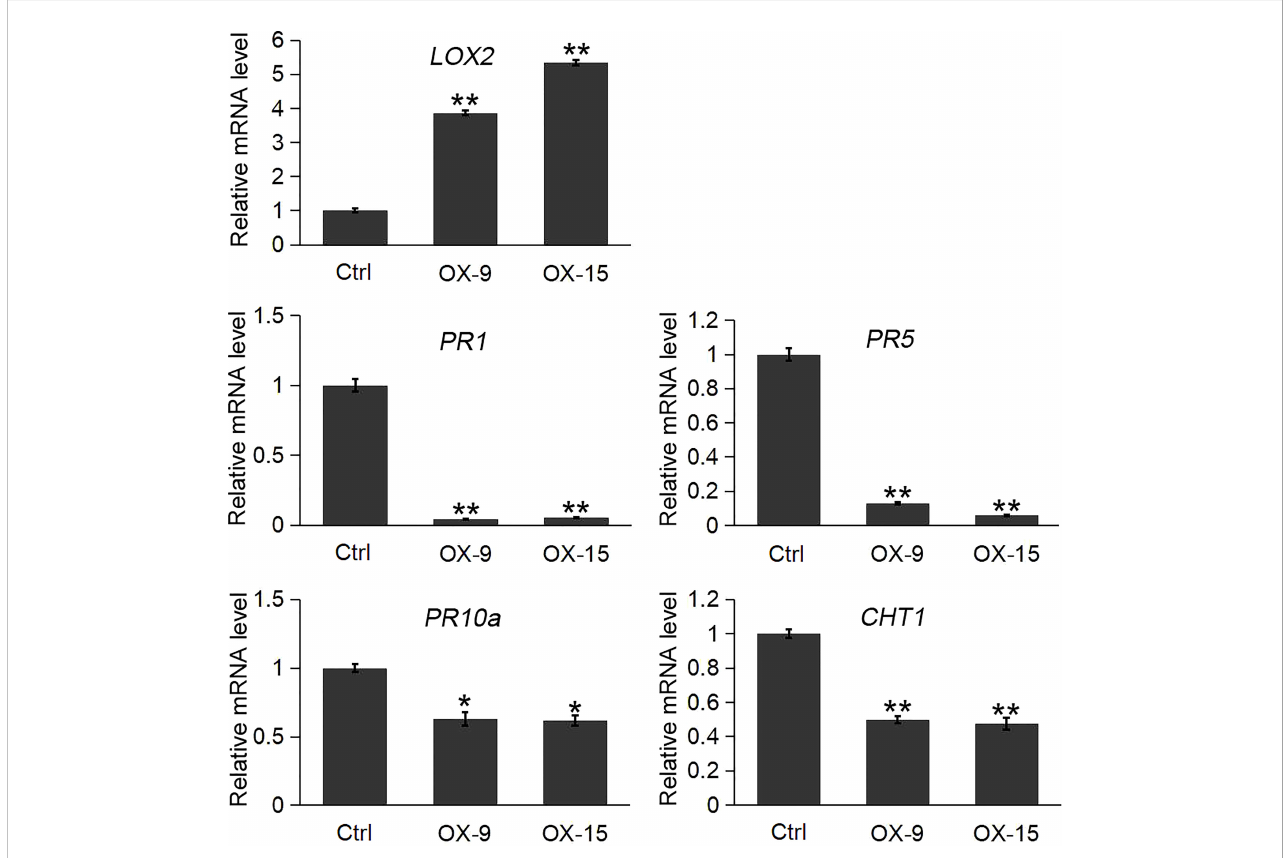
FIGURE 5 Expression analysis of LOX2 and pathogenesis-related ( PR ) genes in the OsGF14C -OX transgenic plants and control plants (Ctrl) by quantitative real-time PCR. Error bars indicate the SD from three biological replicates and asterisks indicate statistically signi fi cant differences compared to the control plants ( t test, ** P <0.01; * P